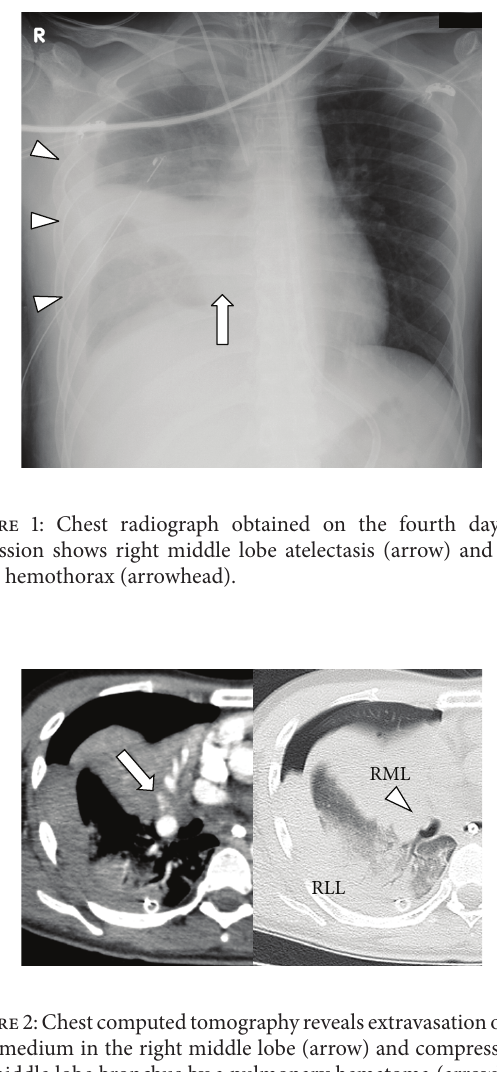
Figure2:Chestcomputedtomographyrevealsextravasationofcon- trast medium in the right middle lobe (arrow) and compression of the middle lobe bronchus by a pulmonary hematoma (arrowhead). RML: right middle lobe; RLL: right lower lobe.